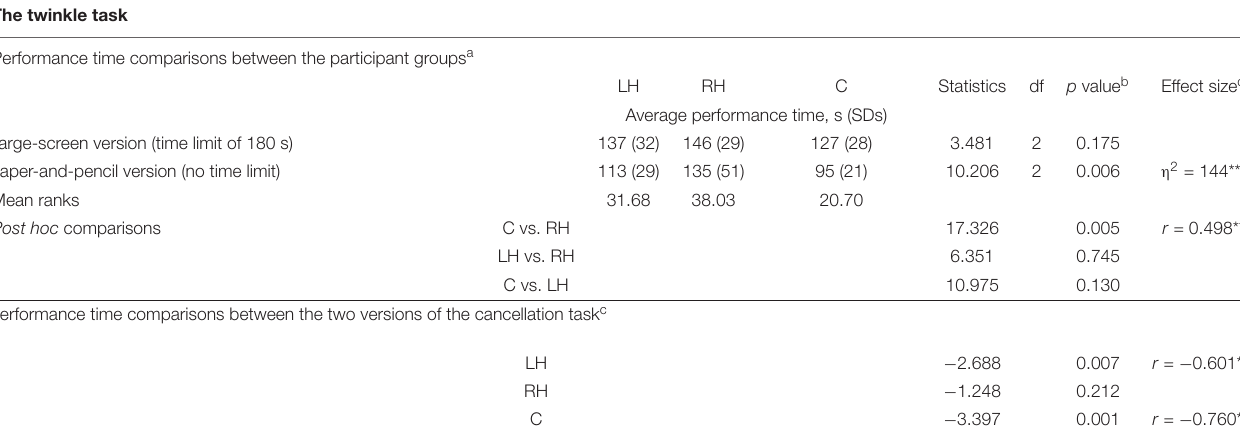
TABLE 4 | Average performance times in the two versions of the cancellation task, and group comparisons. The twinkle